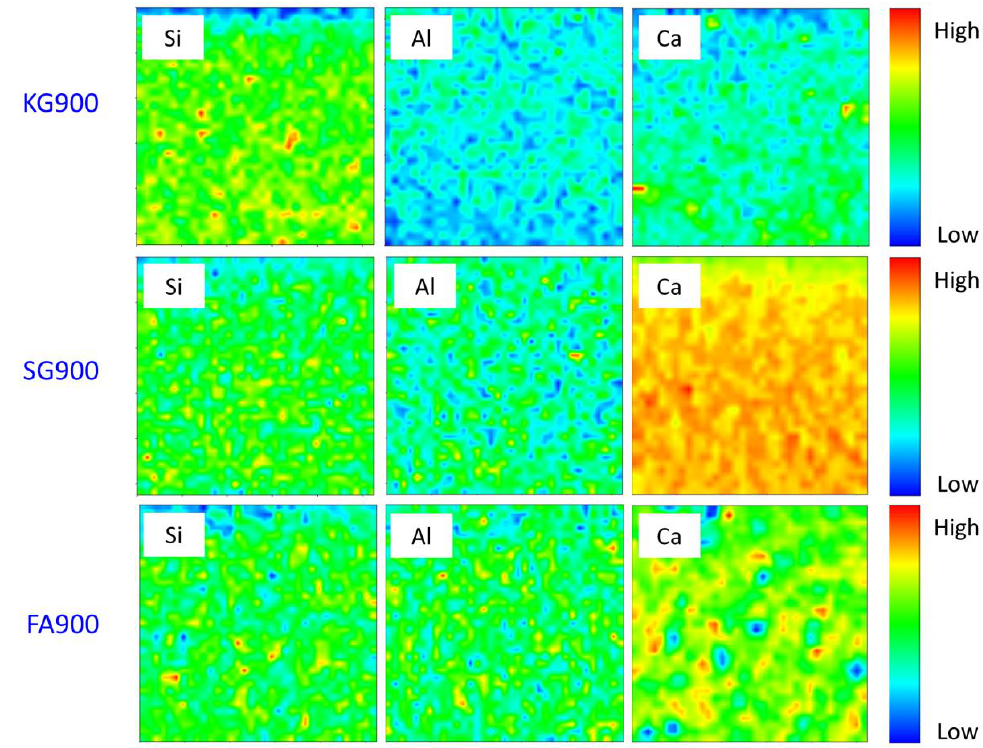
Figure 8. Micro-XRF elemental distribution maps of Si–Al–Ca in the sintered geopolymers at 900 °C.